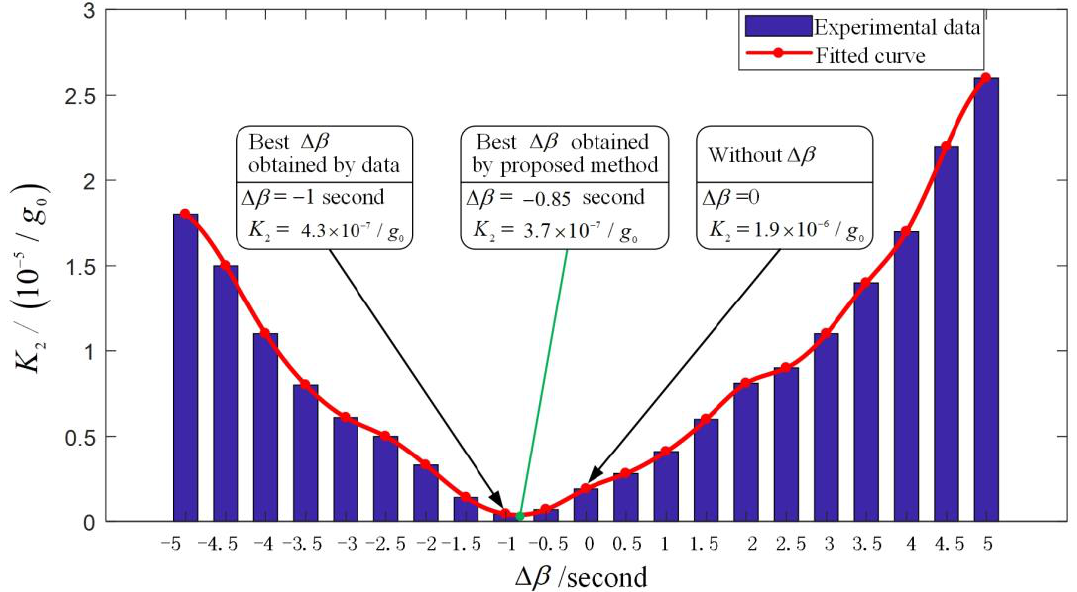
Figure 10. Measured quadratic term error under each ∆ β i ( i = 1, 2, . . . ,21) and best ∆ β selection using the proposed method.